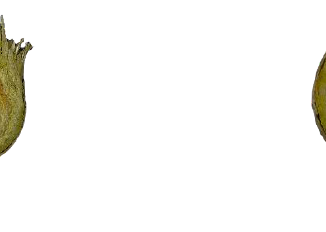
Figure 13. The surface quality of sawing for different diameters.